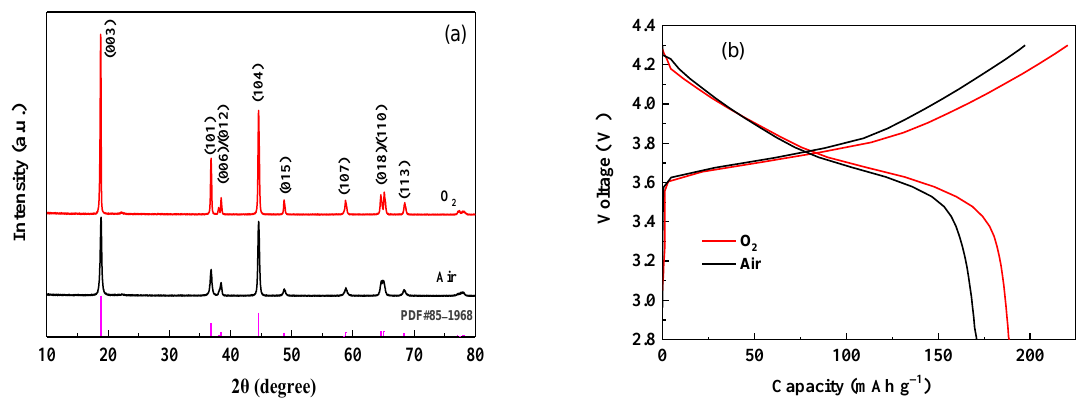
Figure 1. X-ray diffraction (XRD) patterns ( a ) and initial charge-discharge curves at 0.2 C rate ( b ) of LiNi 2/3 Co 1/6 Mn 1/6 O 2 prepared under different atmosphere.